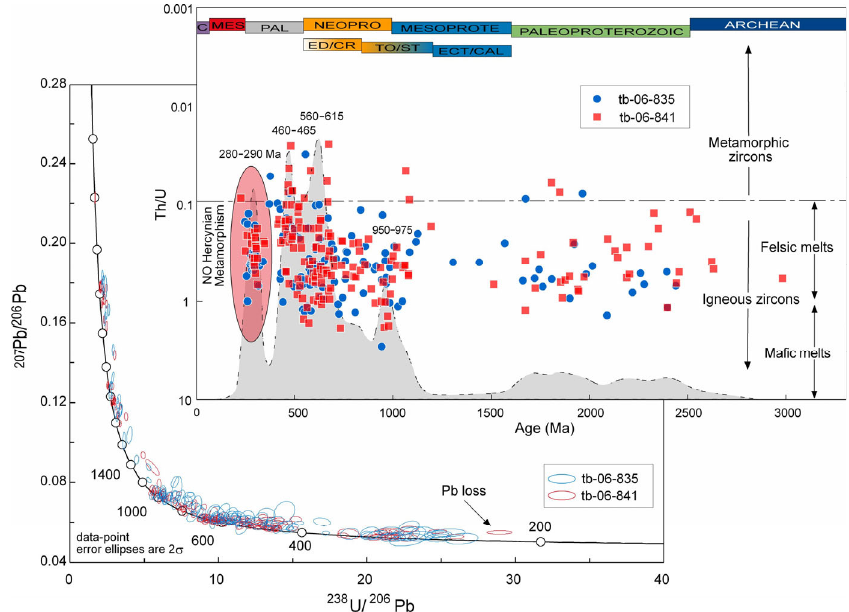
Figure 6. Tera–Wasserburg, KDE age distribution, and Th/U vs. age (Ma) distribution of analyzed samples. The KDE shows the integrated age distribution of both samples.